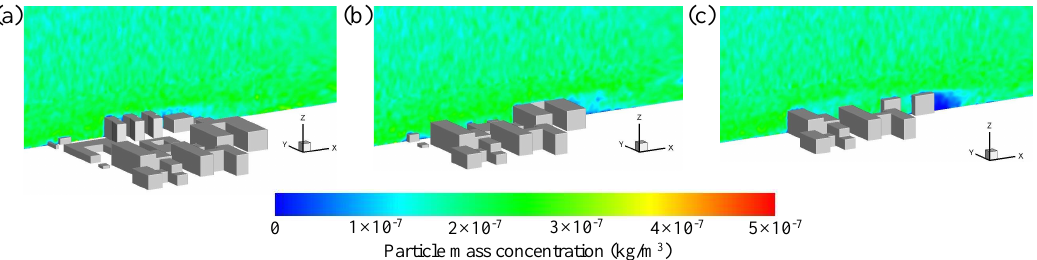
Figure 9. Contours of particle mass concentration on the different vertical planes at t = 670 s: ( a ) y = − 50 m, ( b ) y = 0 m and ( c ) y = 100